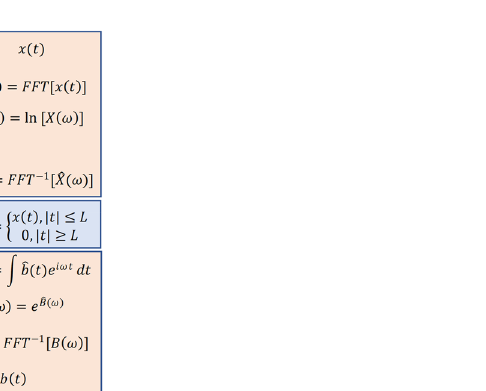
Figure 2. The seafloor sound velocity varies with frequency and the correlations between seafloor reflection coefficient and sediment physical properties: ( a ) variation in sound velocity and frequency; ( b ) variation in reflection coefficient with porosity (f = 5 kHz); ( c ) variation in reflection coefficient with density (f = 5 kHz); ( d ) variation in reflection coefficient with mean grain size (f = 5 kHz).